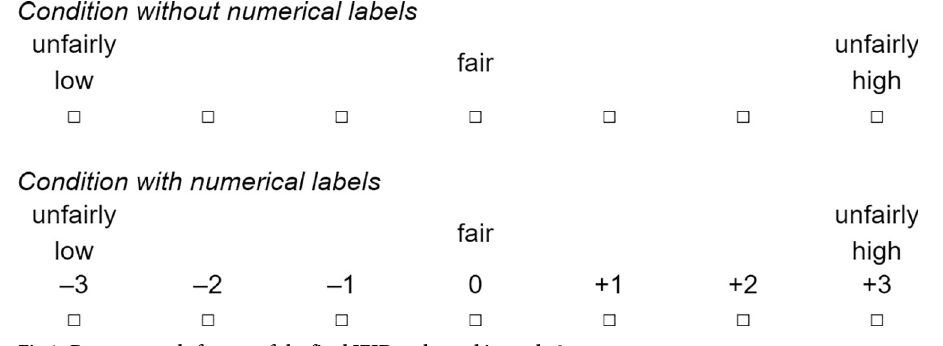
Fig 1. Response scale format of the final JEID scale used in study